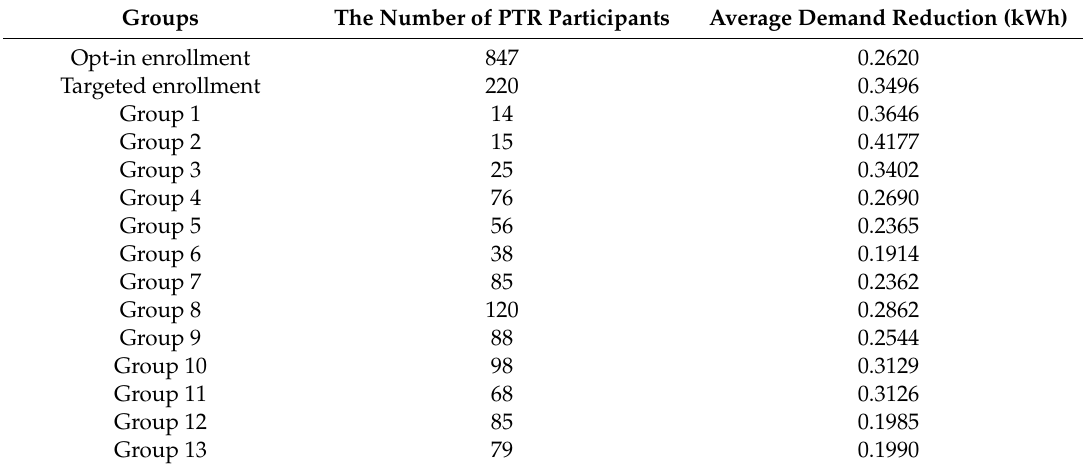
Table 4. Average demand reduction for event days per residential customers during the Peak Time Rebate (PTR) pilot